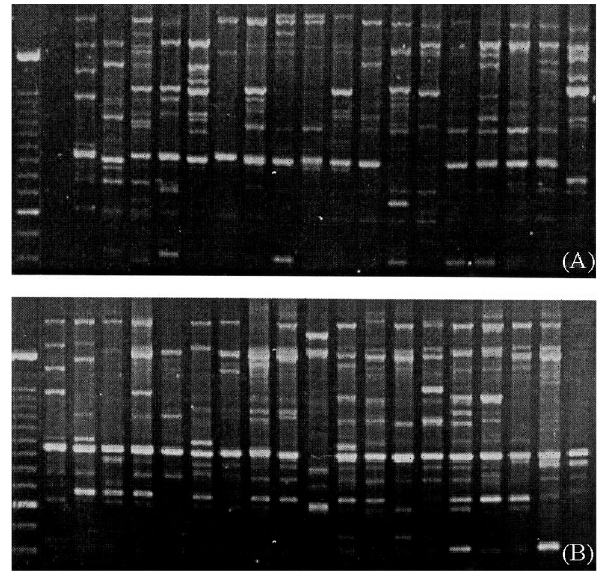
Figure 3 - RAPD profiles for Astyanax altiparanae using primer OPW- 09. ( A ) Individuals from the Keller River (lanes 3-11) and from the Pirapó River (Lanes 12-20), both from the Upper Paraná basin. Lane 2 is a nega- tive control, without DNA. ( B ) Individuals from the Iguaçu River (Lanes 3-20). Lane 2 is a PCR replicate from Lane 3 of A. Lane 1 in A and B con- tains DNA molecular weight markers (Ladder 100 bp, Gibco